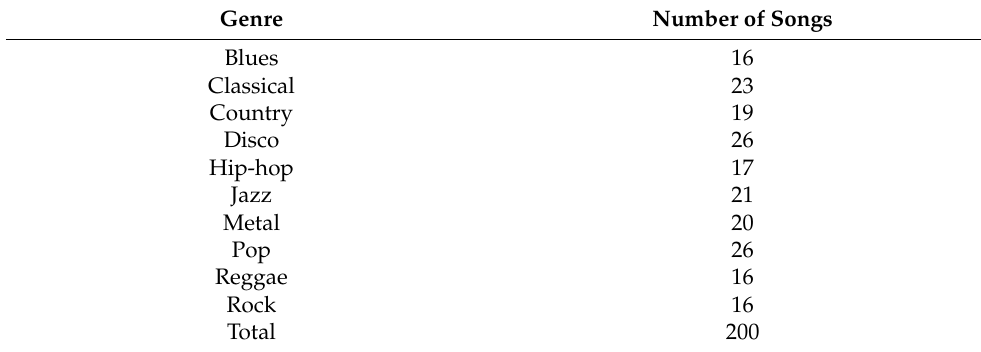
Table 4. Number of songs in 10